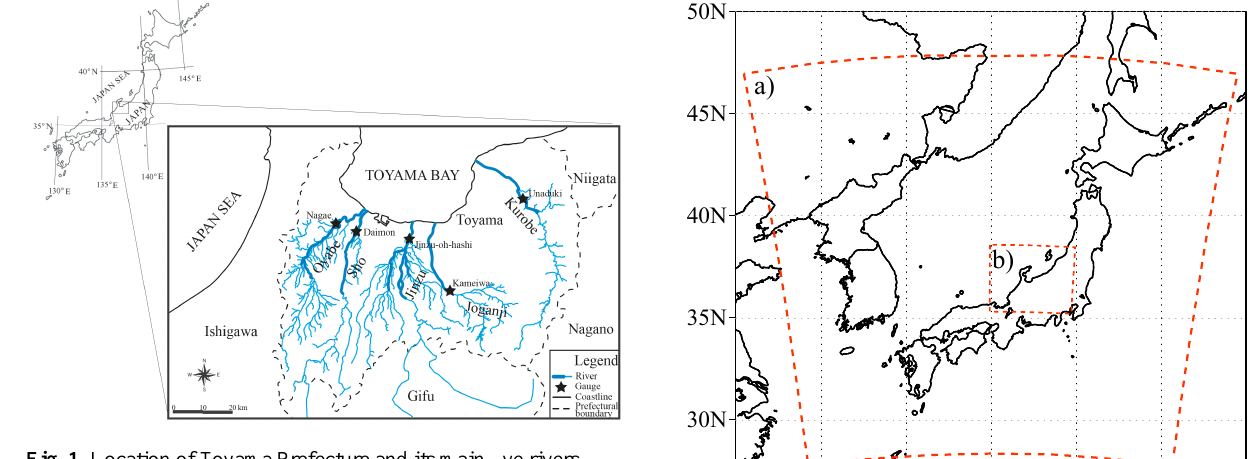
Fig. 1. Location of Toyama Prefecture and its main five rivers.